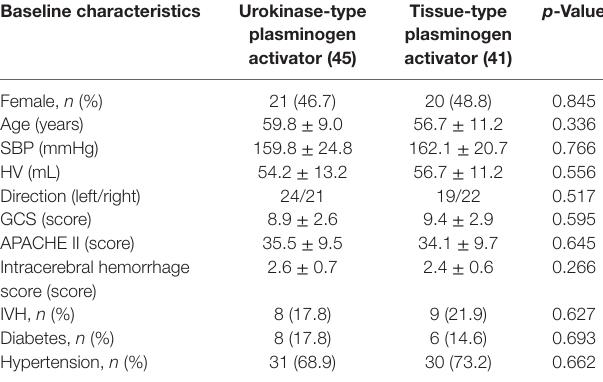
TaBle 1 | Clinical baseline characteristics of